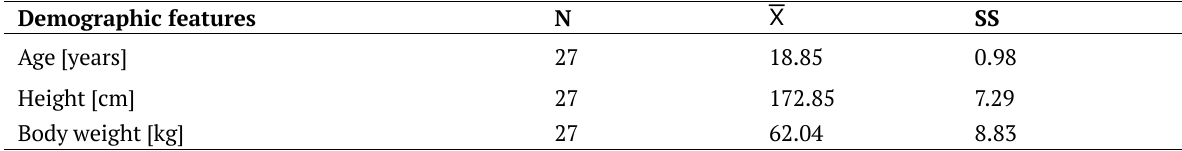
Table 2. Descriptive data of all participants Demographic features